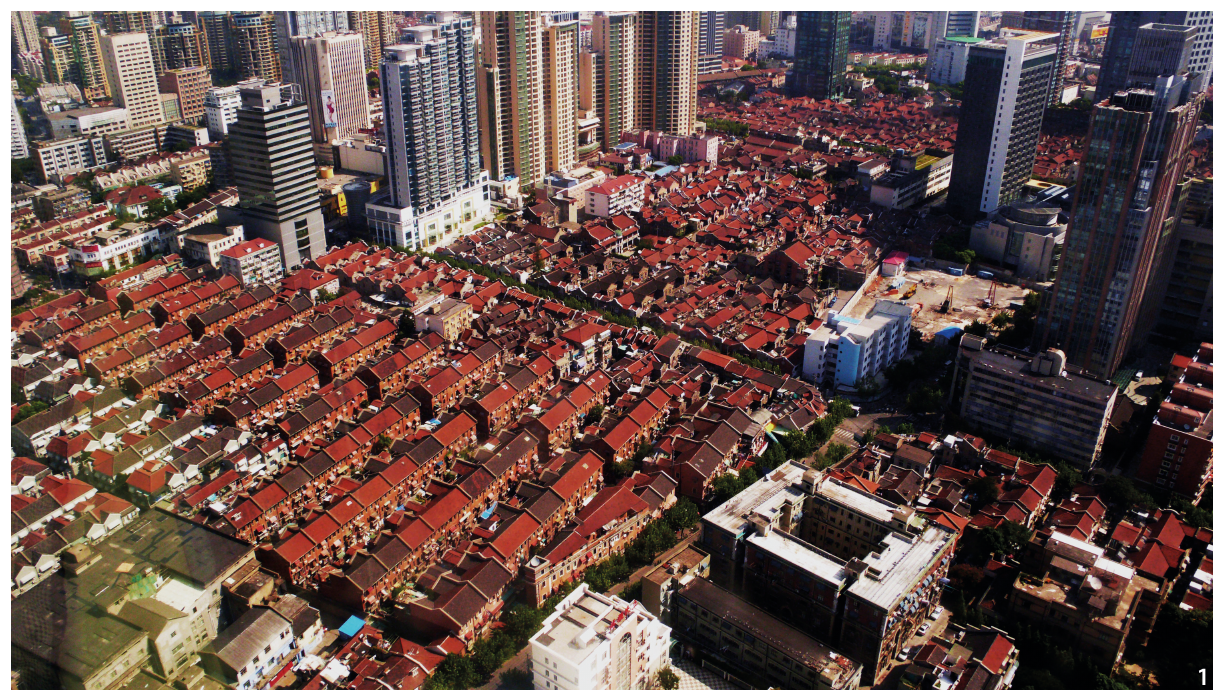
Figure 1 Coexistence of the early-twentieth-century lilong houses and the late 20 th century high–rise buildings (Source: Institute of Shanghai